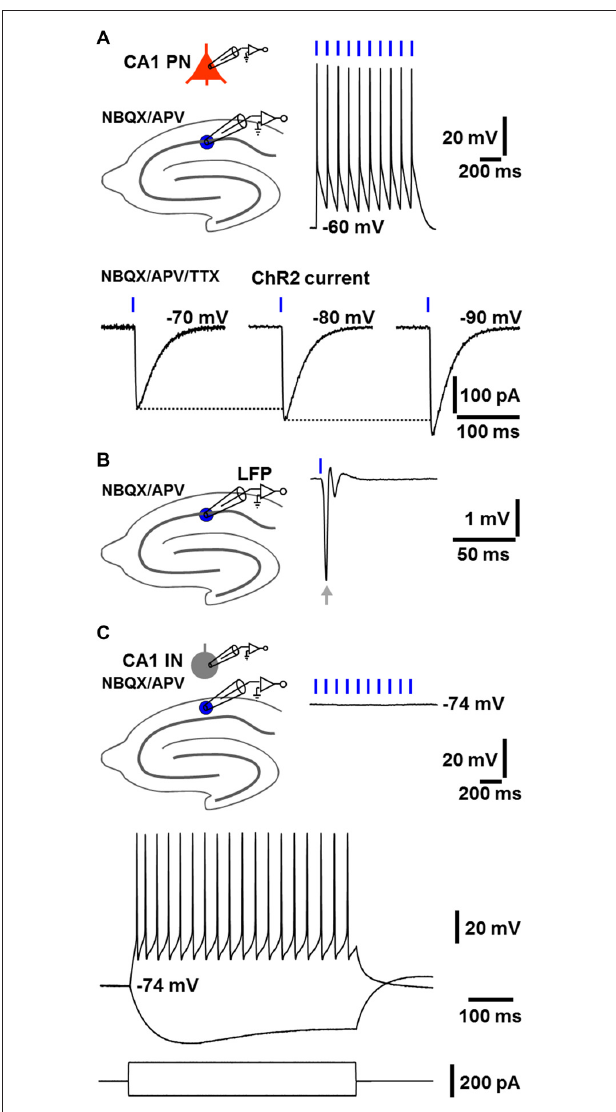
FIGURE 1 | NEX-Cre-Channelrhodopsin-2 (ChR2) mice express functional ChR2 selectively in glutamatergic cells. (A) As measured by whole-cell patch-clamp recordings under blockade of ionotropic glutamate receptors by 2,3-dihydroxy-6-nitro-7-sulfamoyl-benzo[f]quinoxaline-2,3-dione (NBQX) and (2R)-amino-5-phosphonovaleric acid (APV), CA1 pyramidal neurons (CA1 PNs) reliably fired action potentials in response to blue light pulses (2 ms). Consequently, ChR2 currents, which increased with more negative membrane potentials, could be detected in CA1 PNs (extracellular solution additionally contained the sodium channel blocker tetrodotoxin, TTX). (B) As revealed by local field potential (LFP) recordings in the CA1 stratum pyramidale, a single light pulse invariably triggered a prominent population spike generated by CA1 PNs (arrow, extracellular solution contained NBQX and APV). (C) CA1 stratum oriens interneurons (CA1 INs), which exhibited firing characteristics of fast-spiking interneurons upon positive current injection, showed no membrane potential deflections in response to blue light pulses (extracellular solution contained NBQX and